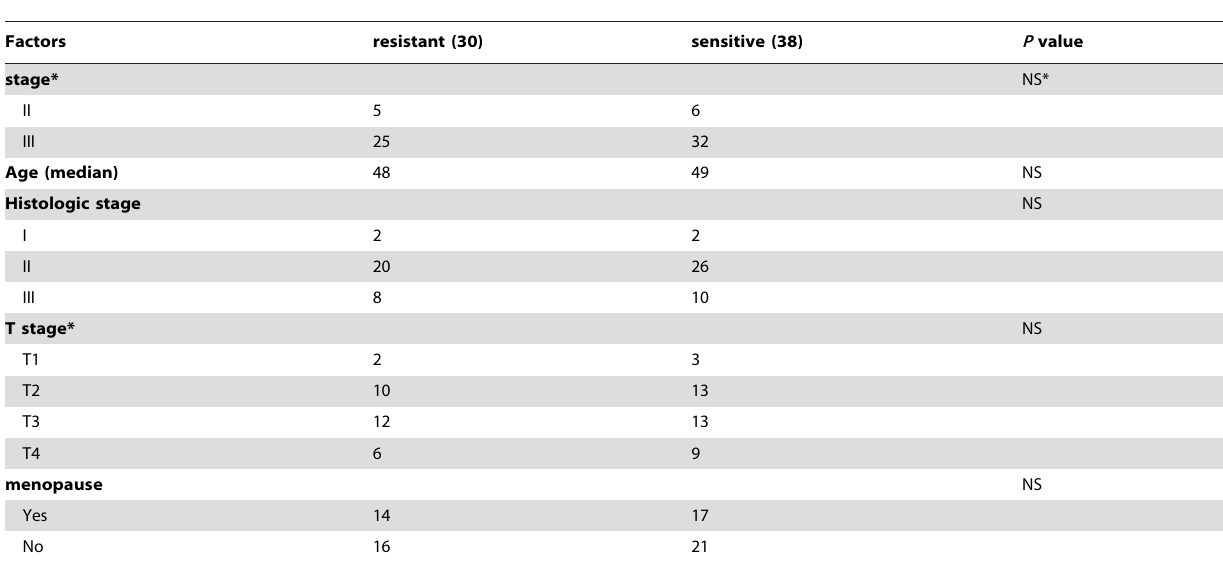
Table 1. Clinical pathological factors between the sensitive and resistant groups.